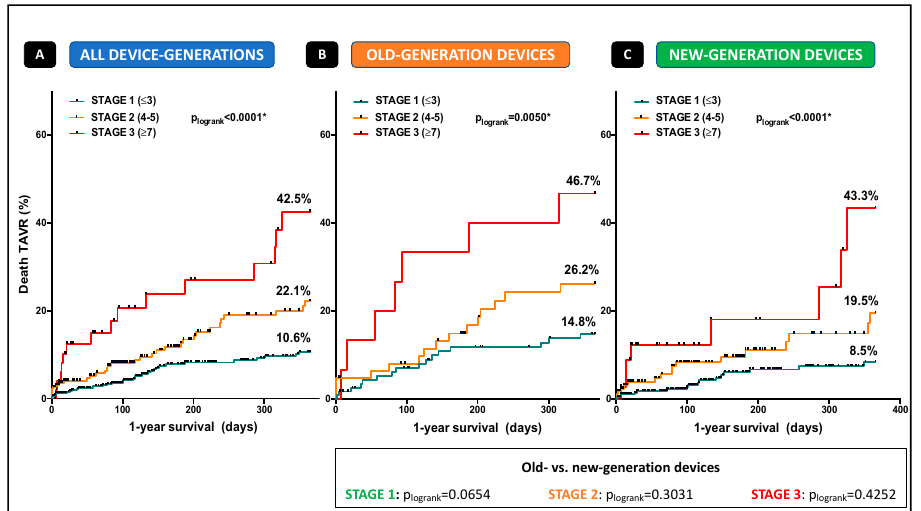
Figure 2. Kaplan-Meier survival curves for 1-year mortality according to the staged risk stratification and device-generation. ( A ) Kaplan-Meier survival curves according to the staged risk stratification in the overall cohort ( B ) using the old-generation, and ( C ) new-generation